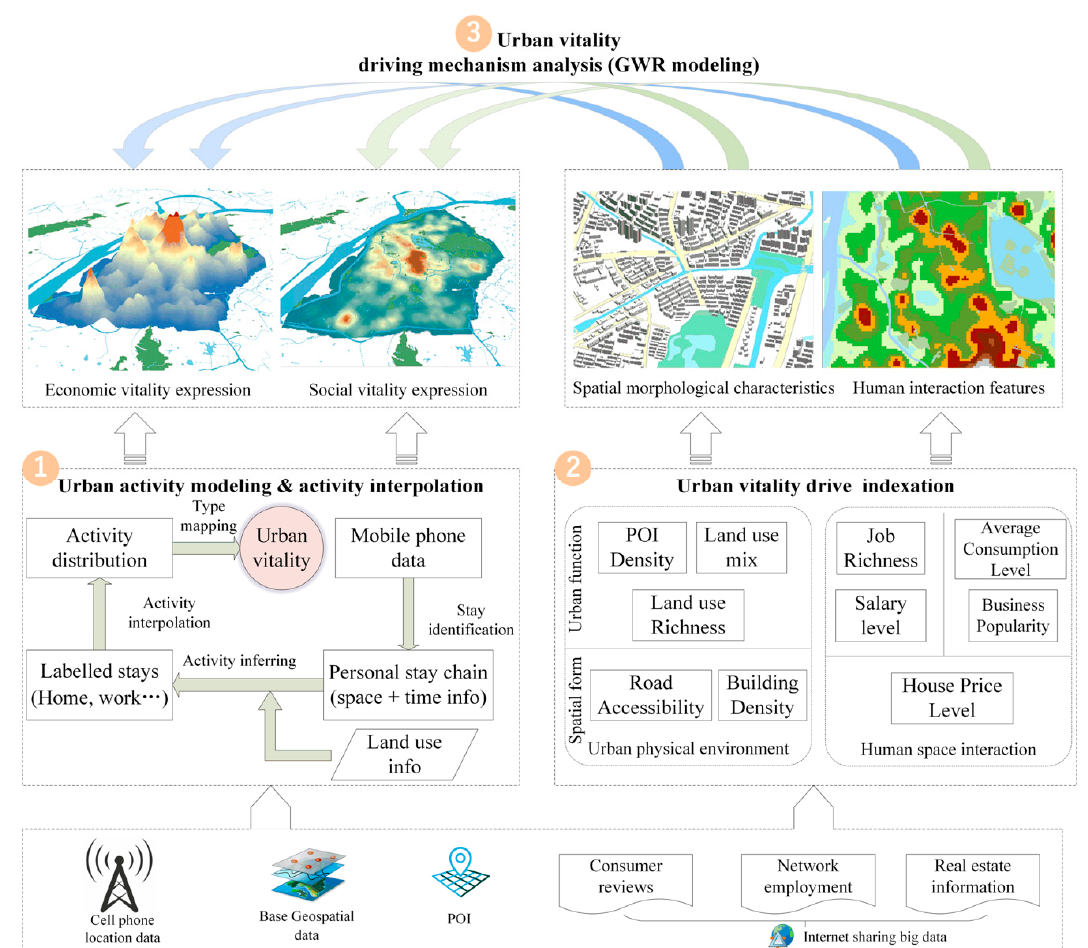
Figure 1. The conceptual framework of urban vitality evaluating proposed in this paper. As shown in the bottom of Figure 1, three types of big data, which include mobile phone location data, geospatial big data, and internet sharing data, are used as the data source for human